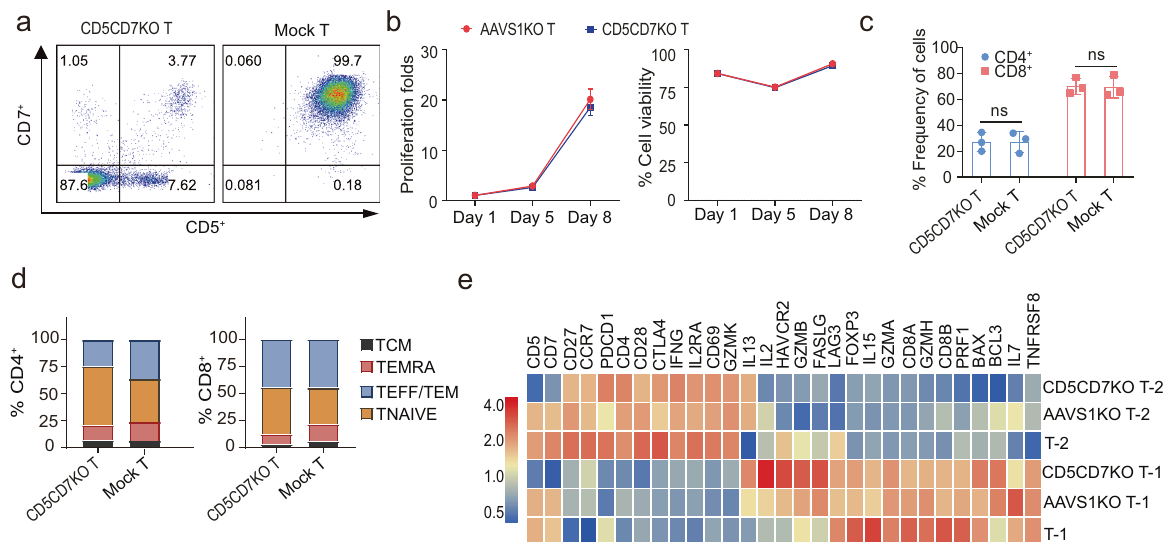
Fig. 1 Disruption of CD5 and CD7 genes in T cells with CRISPR/Cas9 system. a Representative dot plots showing expression of CD5 and CD7 in CD5CD7KO T and mock T cells determined 3 days post electroporation with Cas9 protein, CD5 sgRNA-7, and CD7 sgRNA-85 using fl ow cytometry. b Proliferation and cell viability of CD5CD7 knockout T cells. Knockout of Adeno Associated Virus Integration Site 1( AAVS1 ), a safe harbor locus was used as a control. c The populations of CD4 + /CD8 + T cells in CD5CD7KO T and mock T cells. The data represents mean ± SD for three donors. ns, no signi fi cance, two-way ANOVA. d The frequencies of effector and effector memory (TEFF/TEM; CCR7 − CD45RA − ), terminally differentiated effector memory (TEMRA; CCR7 − CD45RA + ), naïve (TNAIVE; CCR7 + CD45RA + ), and central memory (TCM; CCR7 + CD45RA - ) in CD5CD7KO T and mock T cells were measured using fl ow cytometry on days 7 – 10. The data represents the average from three donors. e Heatmap of selected genes related to T-cell activation, exhaustion, cytokine production, differentiation, and function-related Tandem use of CD5-FHV H 61 and CD7-FHV H 3 can speci fi cally recognize single antigen-positive (CD5 - CD7 + or CD5 + CD7 - ) cells (Fig. 3b and Supplementary Fig 7), though af fi nity measurement using the Octet96e system showed that the order of connection affects the af fi nity of CD5/CD7 bispeci fi c antibodies (Supplemen- tary Fig. 8). Degranulation was a prerequisite for perforin-granzyme- mediated tumor-killing of CAR-T cells, CD5/CD7 bispeci fi c CAR-T